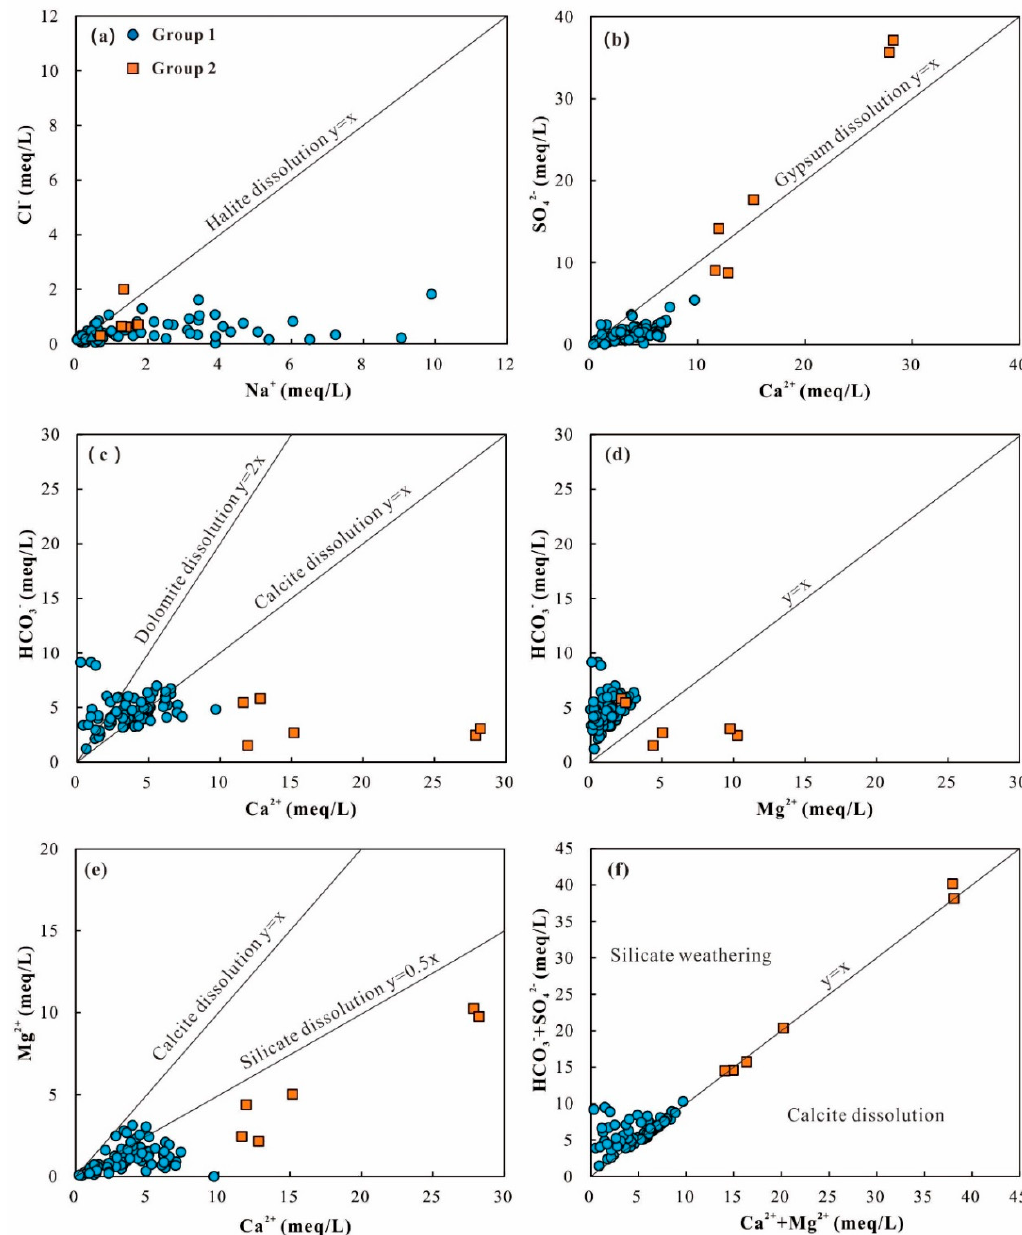
Figure 6. Relationships between major ion concentrations of groundwater samples, ( a ) Cl − vs. Na + , ( b ) SO 42 − vs Ca 2 + , ( c ) HCO 3 − vs. Ca 2 + , ( d ) HCO 3 − vs. Mg 2 + , ( e ) Mg 2 + vs. Ca 2 + , and ( f ) HCO 3 − + SO 42 − vs. Ca 2 + + Mg 2 + .